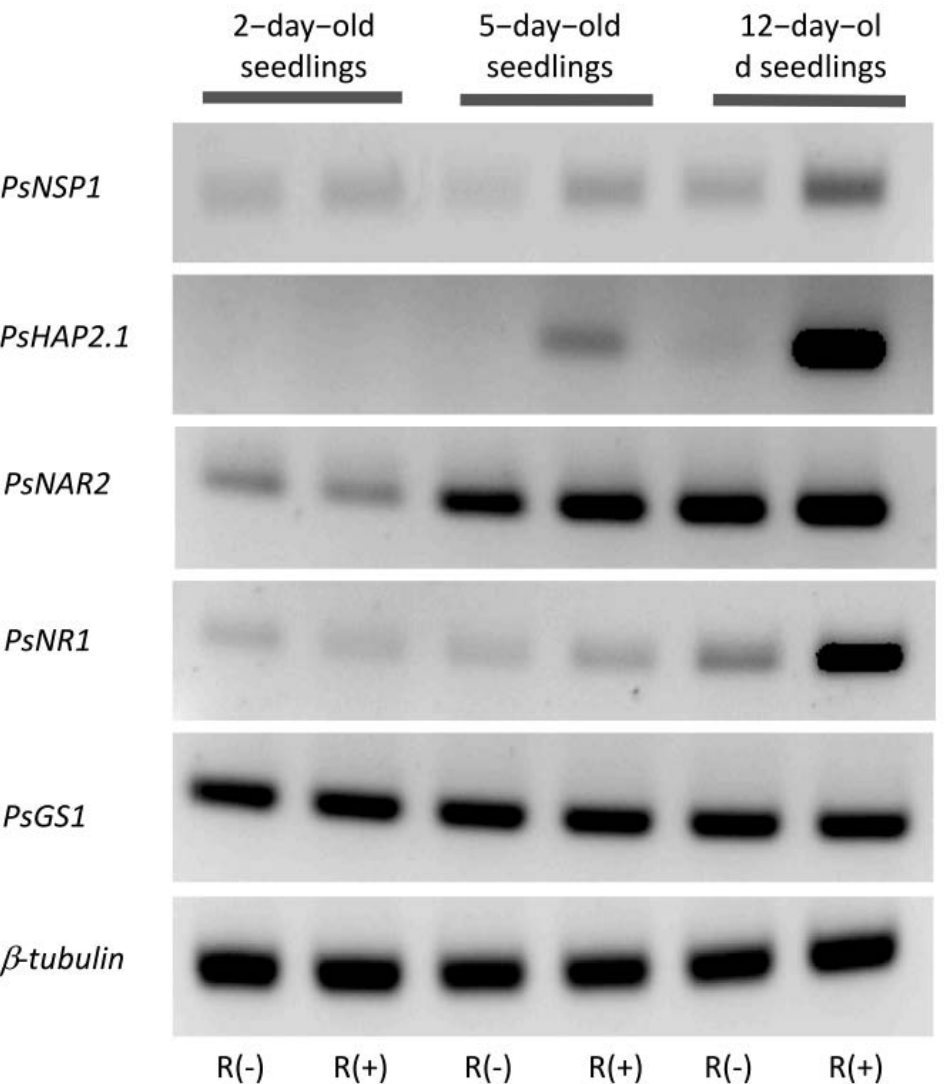
Figure 2. Expression of genes using the semi-quantitative RT-PCR method. Semi-quantitative RT- PCR were performed with root RNAs from 2-, 5-, or 12-day-old seedlings grown in MS without NO 3 − without [R( − )] or with [R(+)] Rhizobium . PsNSP1 , nodulation signaling pathway; PsHAP2.1 , transcription factor of the CCAAT-binding family; PsNAR2 , one component of the high-affinity nitrate transport system; PsNR1 , nitrate reductase; PsGS1 , cytosolic glutamine synthetase. β -tubulin was used as a